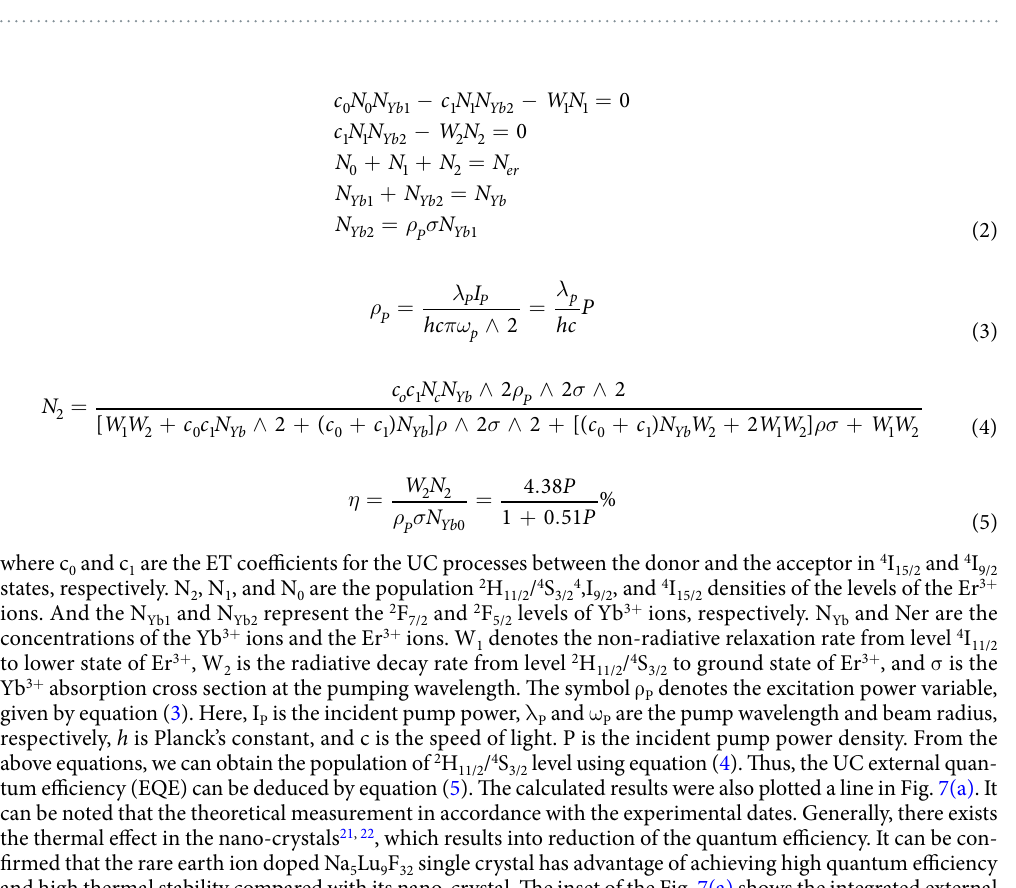
Figure 7. ( a ) Power-dependent UC external quantum efficiency at 980 nm light excitation in Er 3 + /Yb 3 + doped Na 5 Lu 9 F 32 single crystals, the inset shows the external quantum efficiency on Yb 3 + concentrations; ( b ) Comparison of UC external quantum efficiency of Er 3 + /Yb 3 + co-doped Na 5 Lu 9 F 32 /LiYF 4 single crystals under 980 nm